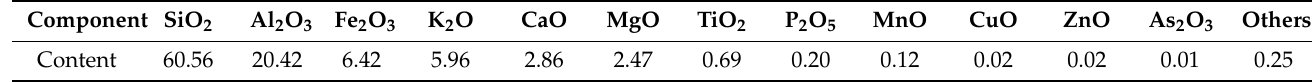
Table 1. The ICP chemical analysis of cyanide tailings